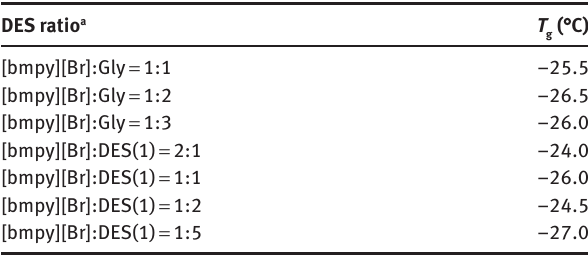
) of the prepared g